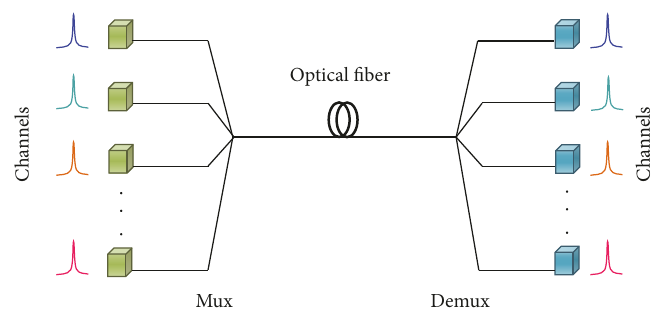
Figure 8: Principle of Wavelength Division Multiplexing (WDM).